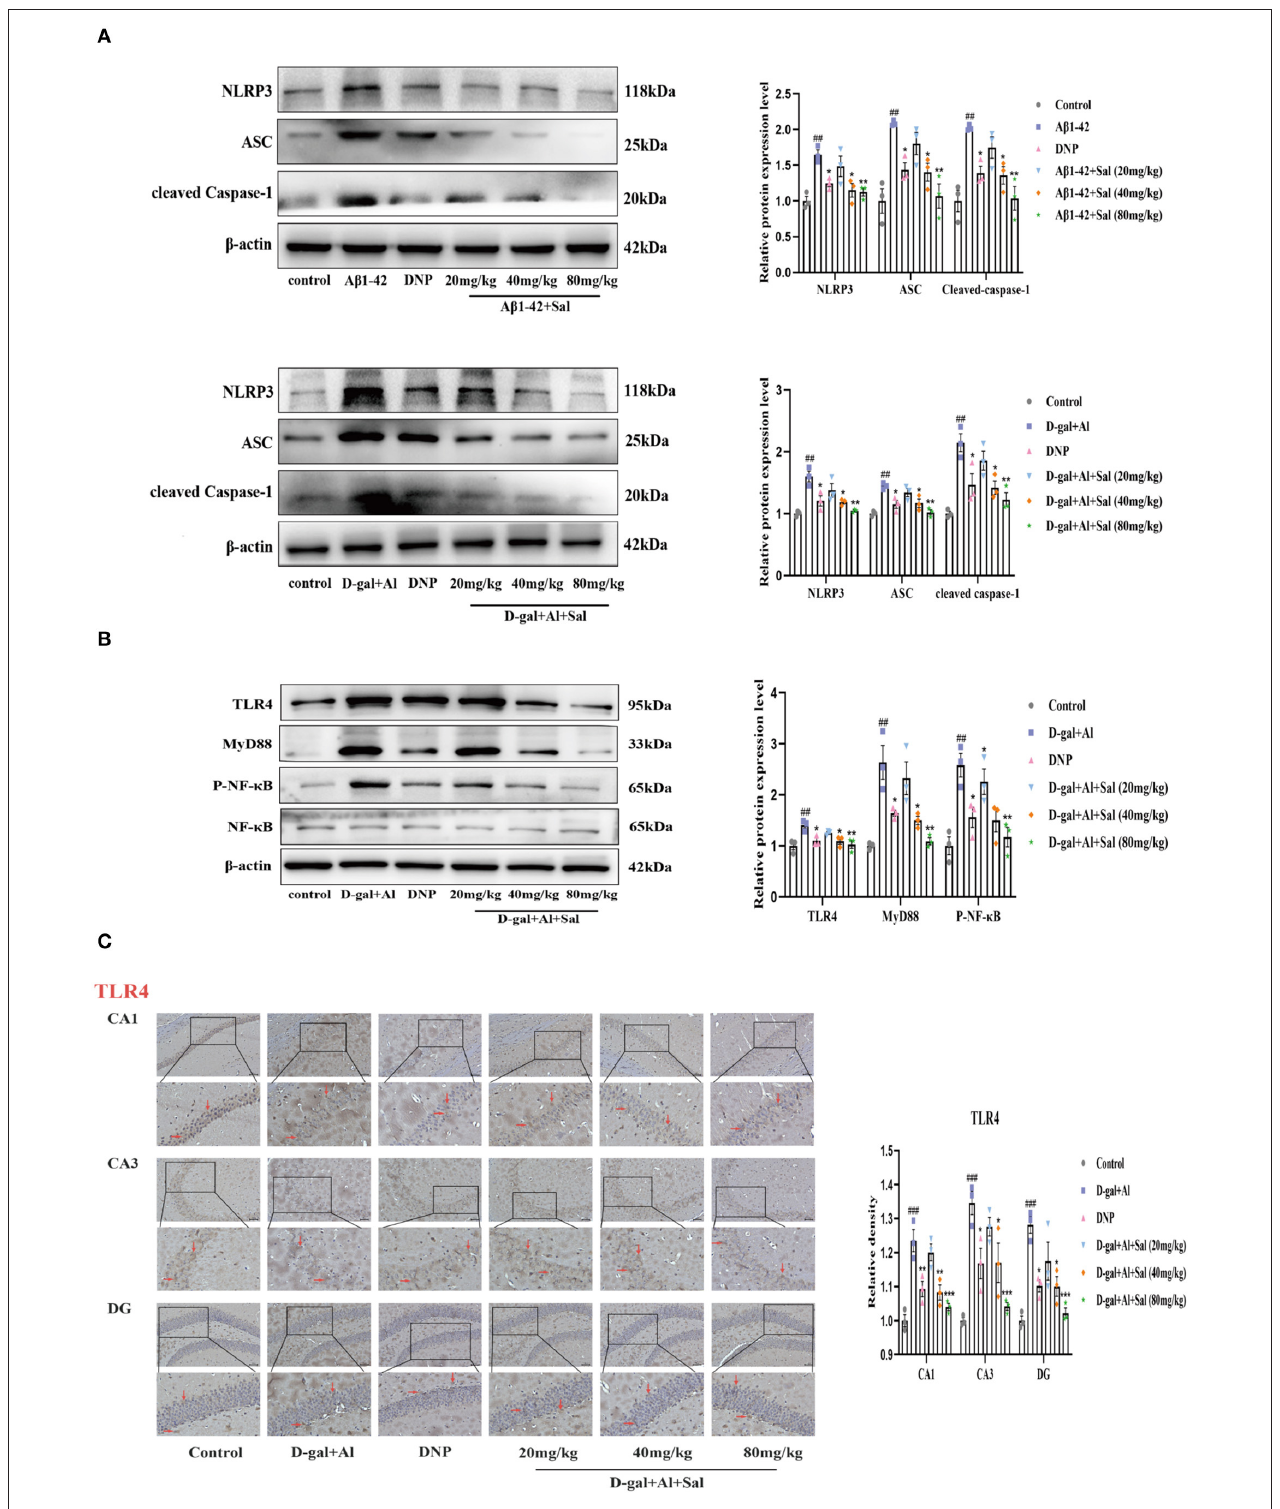
FIGURE 7 | Sal suppressed pyroptosis in A β 1-42 and D-gal/AlCl 3 -induced AD mice via NLRP3/Caspase-1 or TLR4/NF- κ B/NLRP3/Caspase-1 signaling pathway. (A,B) Western blot analysis of TLR4, MyD88, p-NF- κ B, NF- κ B, NLRP3, ASC, and cleaved caspase-1. p-NF- κ B was normalized with NF- κ B and others were normalized with β -actin. (C) Immunochemical staining of TLR4 in the CA1, CA3, and DG regions of the hippocampus of AD mice brains, and the IHC staining results are shown by arrows; scale bar = 50 µ m, Original magnification: x200. Quantitative analyses of the TLR4 positive area in the hippocampus by Image J. Values are expressed as mean ± SEM ( n = 3). ## P < 0.01, ### P < 0.001, vs. control group, * P < 0.05, ** P < 0.01, *** P < 0.01 vs. A β 1-42 and D-gal/AlCl 3 group.